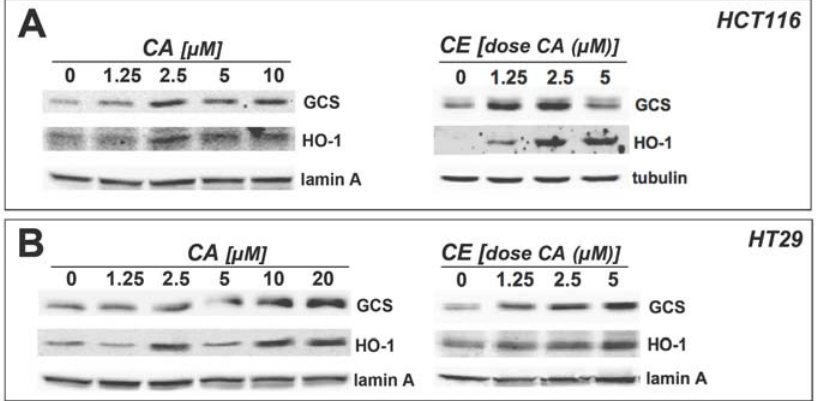
Figure 4. Upregulation of HO-1 and  -GCS protein levels. Cultured human HCT116 (a) and HT29 cells (b) were treated with either CA or CE at the indicated doses normalized for CA content for 24 h. Treatment with tBHQ (100 µM) served as a positive control. Equal loading was assessed by immunodetection of lamin A or  -tubulin.